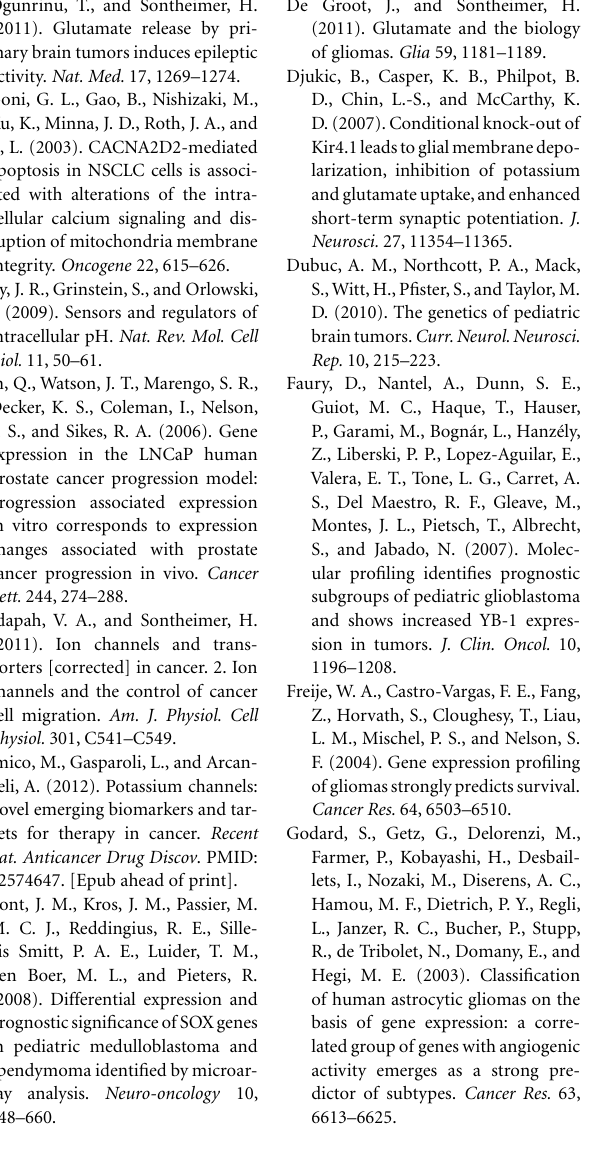
Table S1 | Gene differentially expressed (DE) in gliomas compared to normal brain. About 2284 DE genes identified by One Sample t -test with a p -value < 0.01, fold change ≥ 4, and Bonferroni correction. Table S2 | Functional annotation analyses (FAA) from all DE genes. FAA performed using NIH-DAVID software (version 6.7, http://david.abcc.ncifcrf.gov/) on all the DE genes reported inTable S1 in Supplementary Material.We used the parameter GOTERM_BP_FAT, with the significance p -value threshold set < 0.01, with Bonferroni correction.